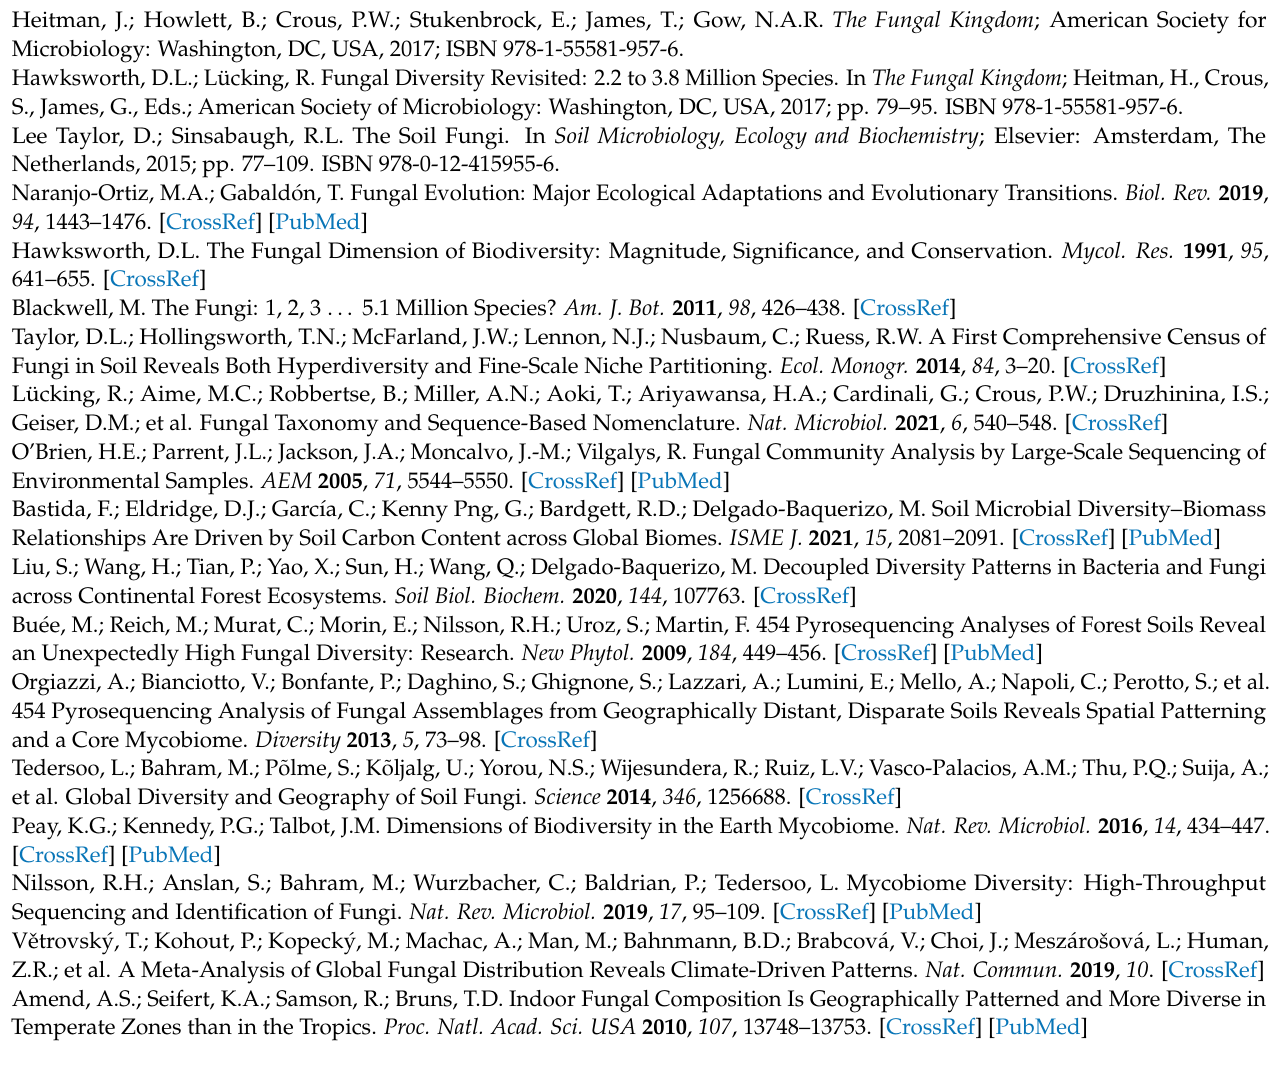
Table S3: PERMANOVA and a posteriori pairwise test; Table S4: Taxonomy classification of OTUs (Operational Taxonomic Unit) using UNITE database